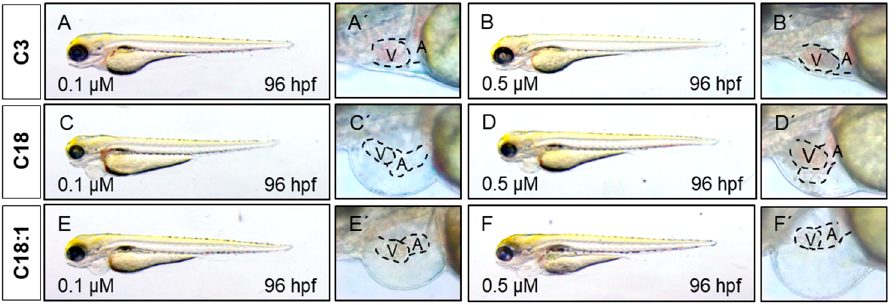
Figure 3. LCAC treatment induces cardiac phenotype in embryonic zebrafish. ( A – F ) Lateral view of embryos after 48 h of incubation with compounds. ( A ′ – F ′ ) Magnified view of hearts from subfigures of embryos after 48 h of incubation with compounds. ( A (cid:48) – F (cid:48) ) Magnified view of hearts from A–F. subfigures A – F